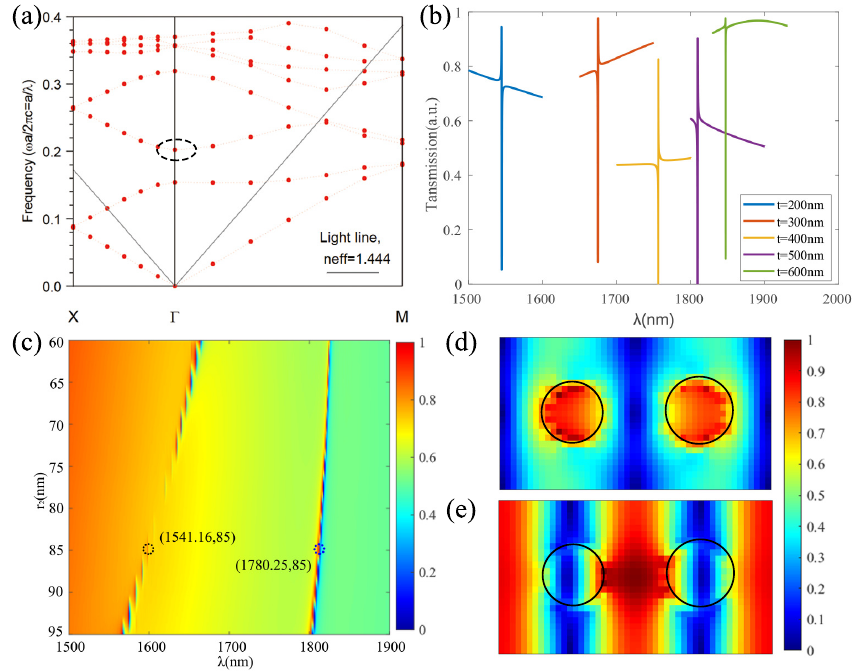
Figure 3. ( a ) Band diagram for rectangular structure with parameters values ra = 0.225, rascal = 1.1. ( b ) Normalized transmission spectra for a = 350 nm, r 1 = 80 nm, r 2 = 85 nm, varying t . ( c ) Normalized transmission spectra for a = 350 nm, t = 200 nm, r 1 = 80 nm, varying r 2 . The wavelength of black dotted circle is 1541.16 nm and the wavelength of blue dotted circle is 1780.25 nm, respectively in r 2 = 85 nm. ( d ) Normalized electric field distribution at 1541.16 nm. ( e ) Normalized electric field distribution at 1780.25